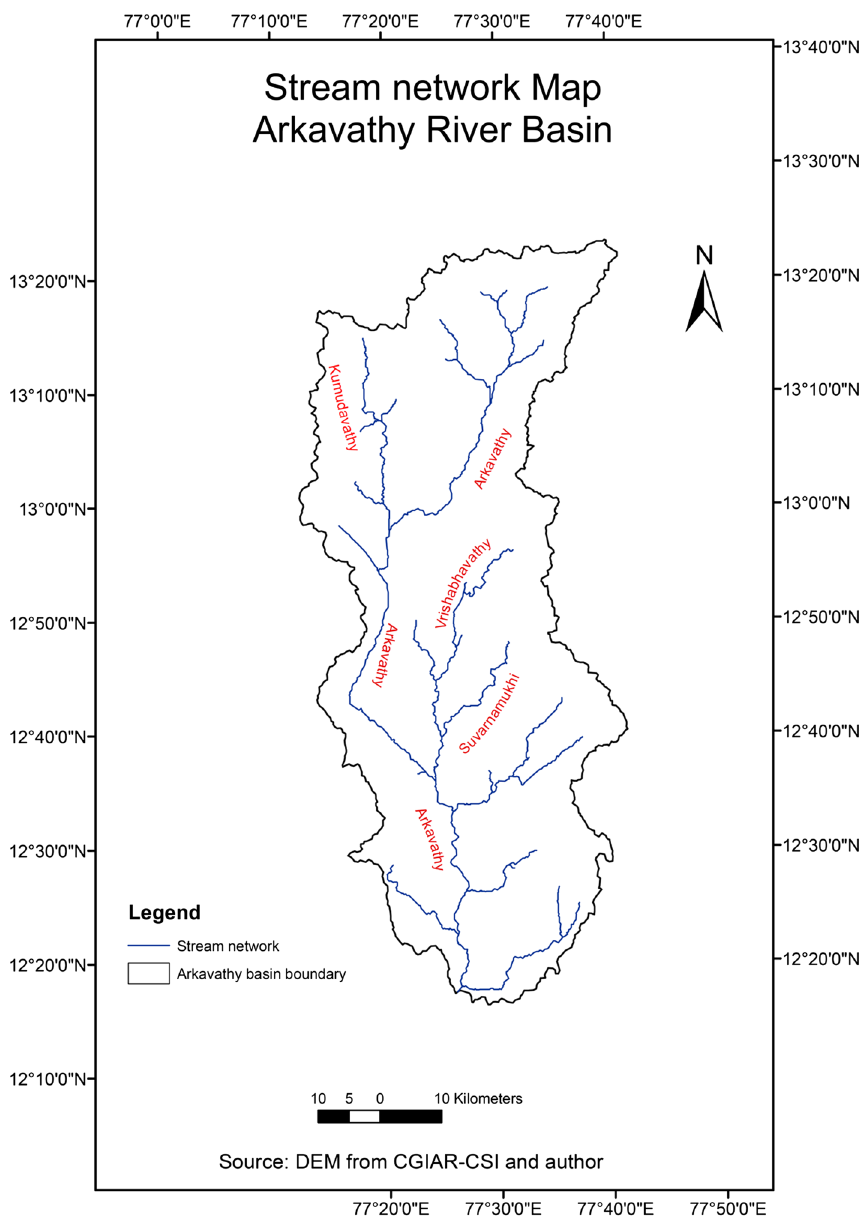
Fig. 2 Stream network in Arka- vathy river